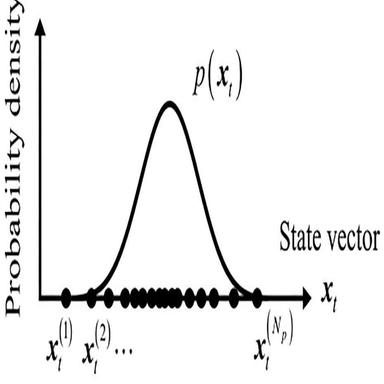
Schematic illustration of the ensemble approximation of a PDF p(xt) using Np ensemble members xt (i) (i = 1, 2, …, Np) shown as black circles.